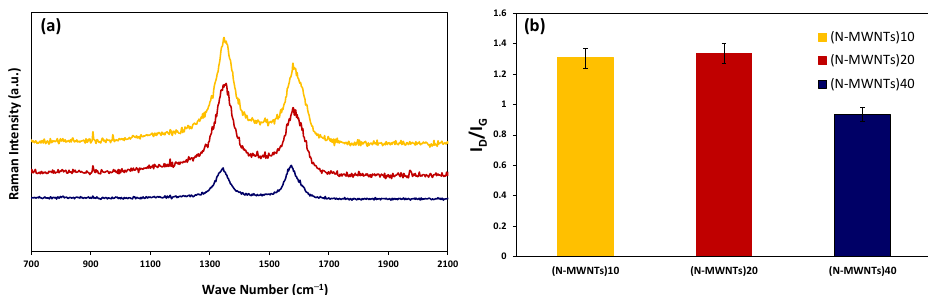
Figure 4. ( a ) Raman spectra of N-MWNTs synthesized using different ratios of catalyst. ( b ) Intensity ratio of D - and G -band (I D /I G ) as a function of different synthesized N-MWNTs.